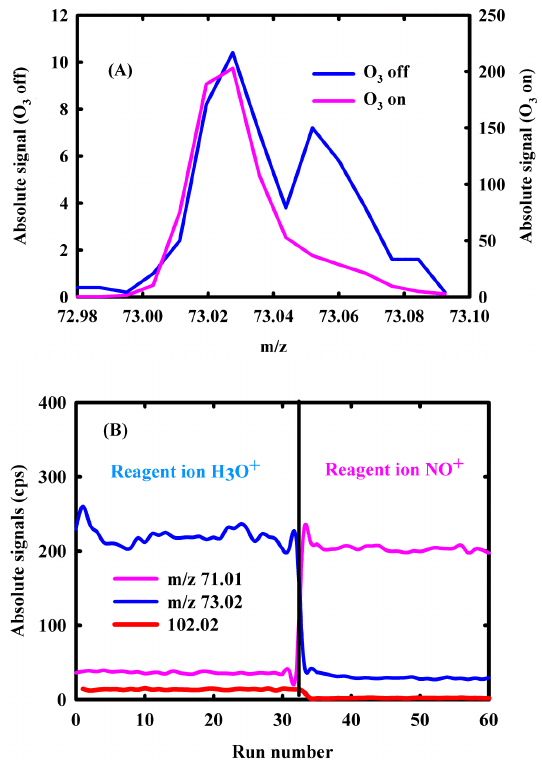
Fig. 3. PTR-TOF-MS mass spectrum of the signal at m/z 73.02 recorded with H 3 O + as the reagent ion (A) and three signals recorded with PTR-TOF-MS as the reagent ion is switched from H 3 O + to NO + (B) from Type 1 experiment with 500 ppb O 3 exposure.